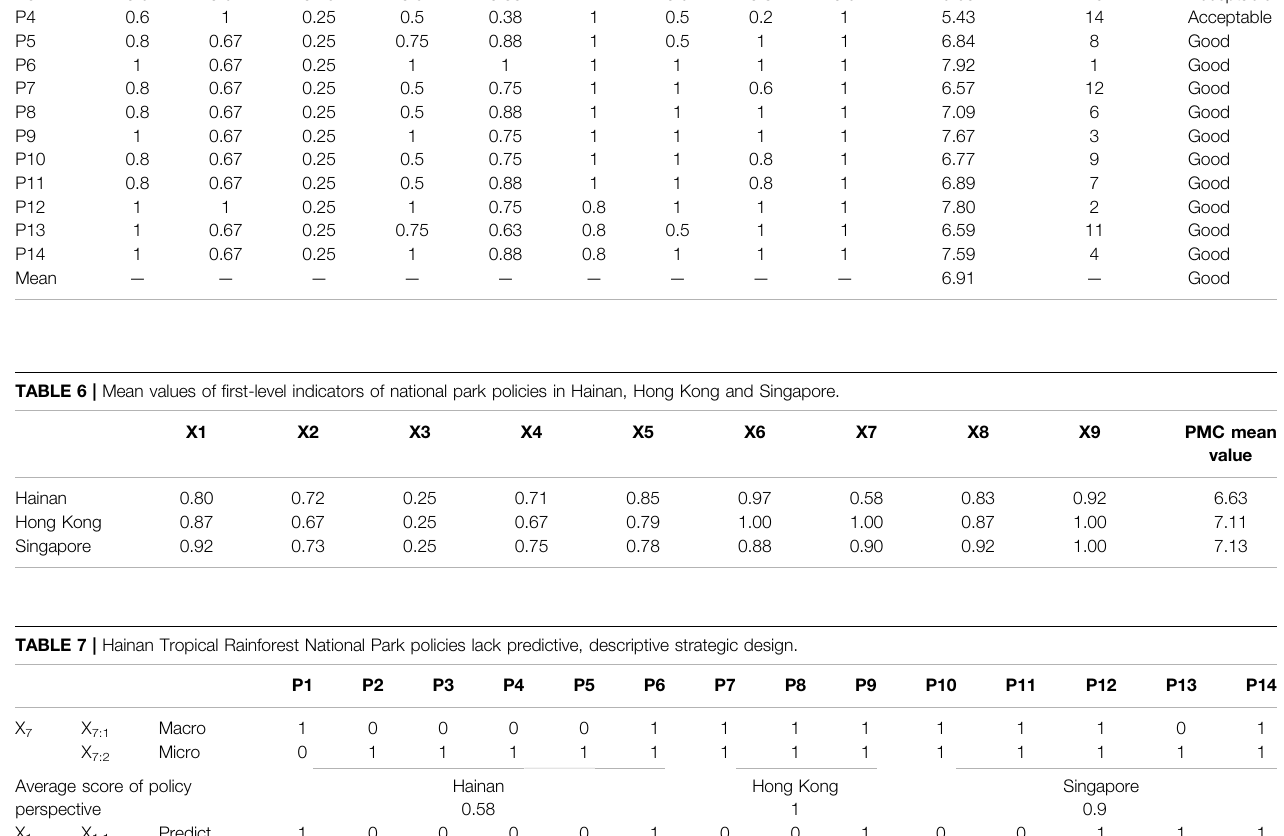
TABLE 5 | PMC Index of national park policies in Hainan, Hong Kong and Singapore. Policy No.